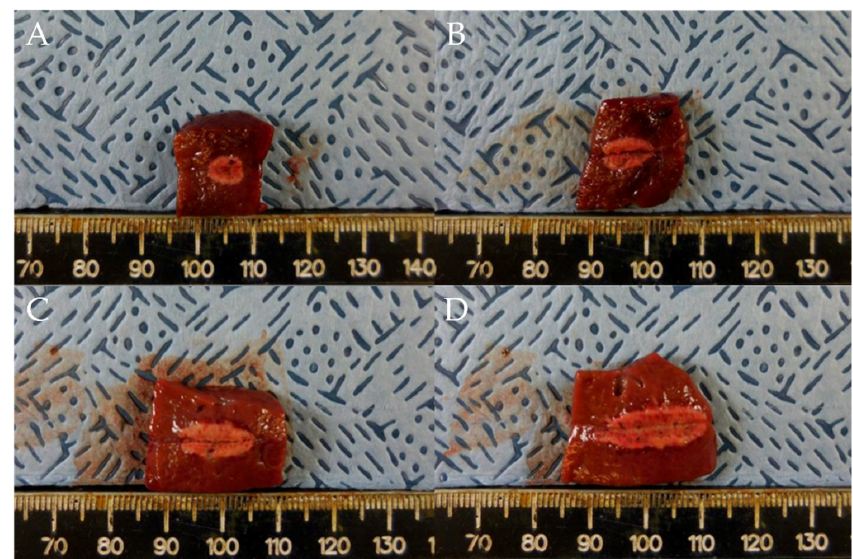
Figure 2. Comparison of ablation zones based on electrode robe length and ablation power. ( A ) 0.5 cm, 10 W, 10 s. ( B ) 0.7 cm, 25 W, 10 s ( C ) 1 cm, 50 W, 10 s. ( D ) 1.5 cm, 75 W, 10 s. Specimens exhibit a well-demarcated ablated lesion that is distinguishable from the surrounding liver parenchyma.